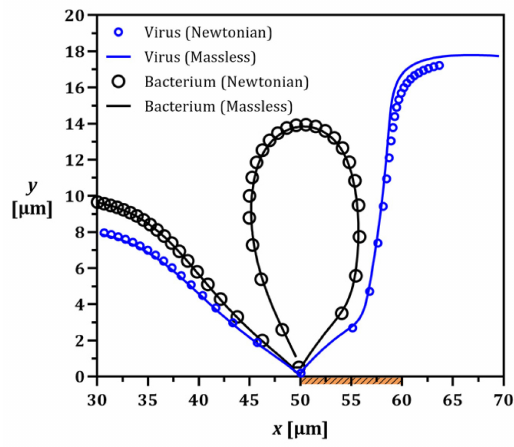
Figure 6. Comparing the trajectories of the electrically neutral bacteria and virus using modified Newtonian and massless models to enable the particle size and wall effects. The virus escapes beneath the vortex while the bacterium is forced to follow the vortex